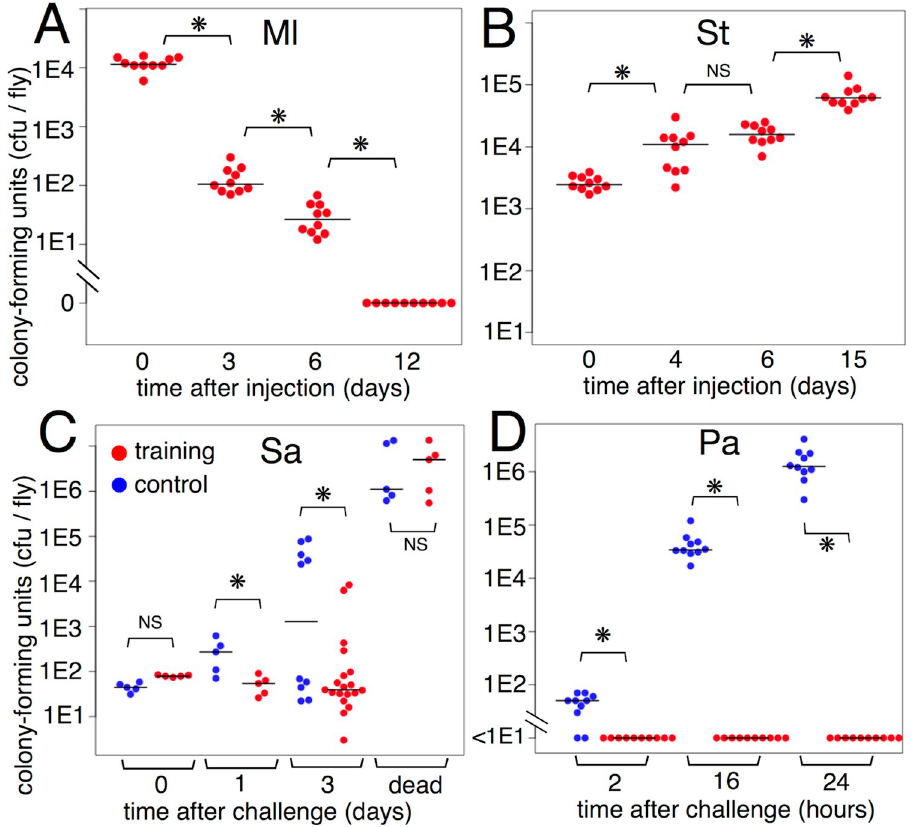
Fig 2. Bacterial load assay for training and challenge. (A, B) Loads of training bacteria, Ml (A) and St (B). The flies were collected at given times post-injection. (C, D) Loads of challenge bacteria, Sa-GFP (C) and Pa-Kan (D). The flies were collected at the indicated times post-challenge. "dead" means the flies died within 24 hours before sample preparation. Asterisks and NS indicate statistically significant (p-value < 0.05) and not significant, respectively, in Kruskal-Wallis ANOVA and post-hoc Wilcoxon rank sum